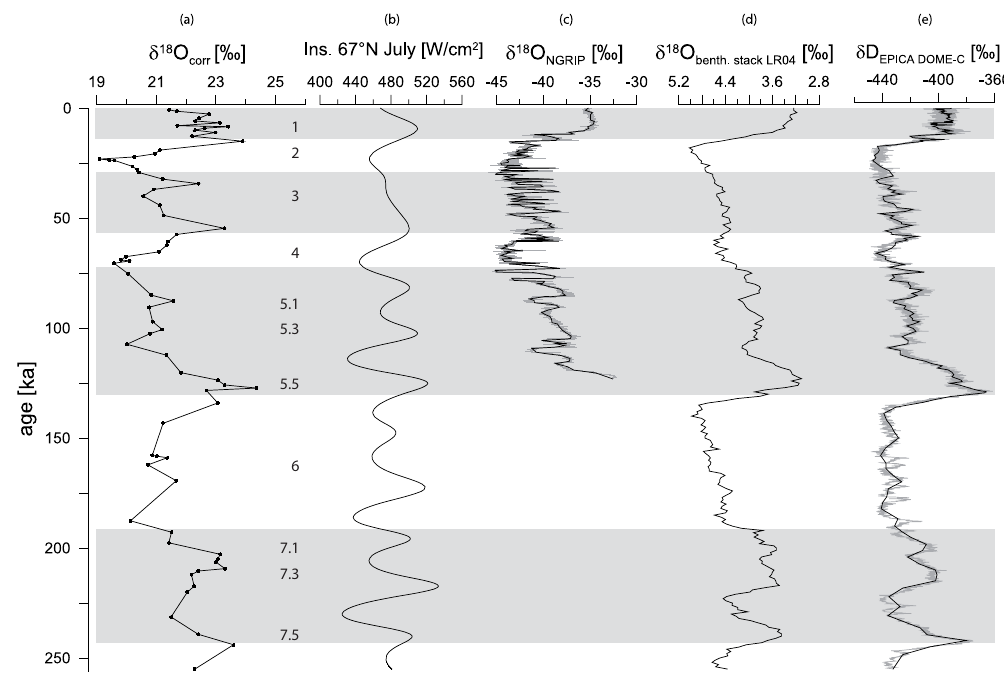
Fig. 8. (a) The δ 18 O diatom record is plotted versus (b) July insolation at 67 ◦ N (Laskar et al., 2004) (c) δ 18 O from the ice-core record NGRIP (North-Greenland-Ice-Core-Project members, 2004) (d) the stacked marine oxygen isotope record LR04 (Lisiecki and Raymo, 2005) and (e) δ D from EPICA Dome-C ice-core record (EPICA members, 2004, 2006). For both ice-core records: complete record in grey; spline smoothing in black. Warmer periods corresponding to MIS 1, MIS 3, MIS 5 and MIS 7 are marked in grey, interglacials and significant interstadials are